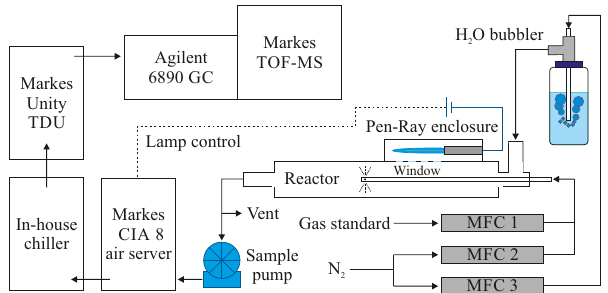
Figure 1. Schematic of the OH reactor configuration used. CIA 8 is the air server and canister interface accessory; GC is the gas chromatograph; MFC is the mass flow controller; TOF-MS is the time-of-flight mass spectrometer; TDU is the thermal desorption unit. The flow rate through MFC 1 was stepped from 200sccm to 1000sccm in 200sccm intervals. The combined flow rate through MFC 1 and MFC 2 was kept constant at 1000sccm. The flow rate through MFC 3, and hence through the H 2 O bubbler, was set to 2000sccm, resulting in a total flow through the reactor of 3000sccm. The residence time of VOC inside the reactor after in- jection was approximately 4s, with the oxidation chemistry ex- pected to occur in under